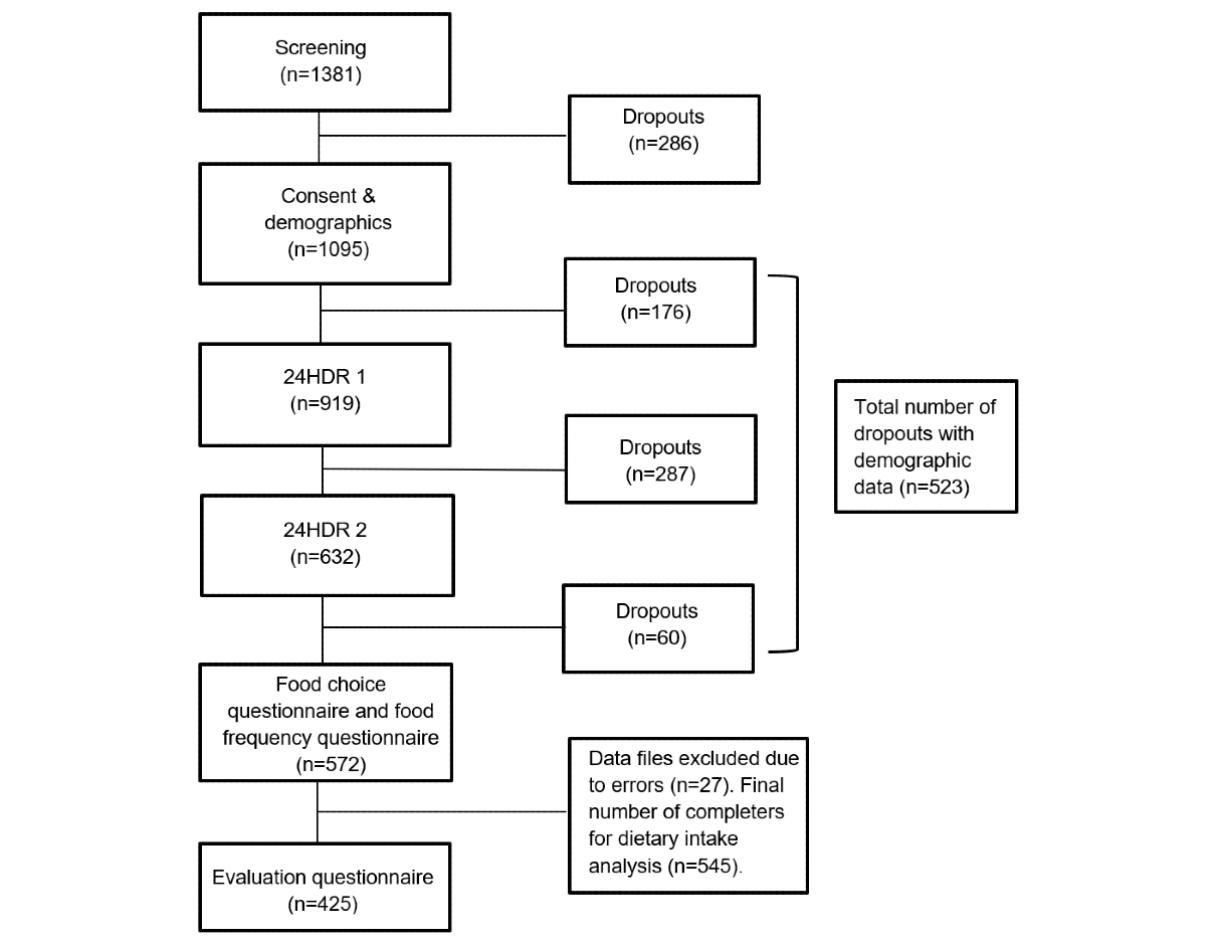
Figure 1. Stages of the Foodbook24 tool in the web-based study. 24HDR: 24-hour dietary